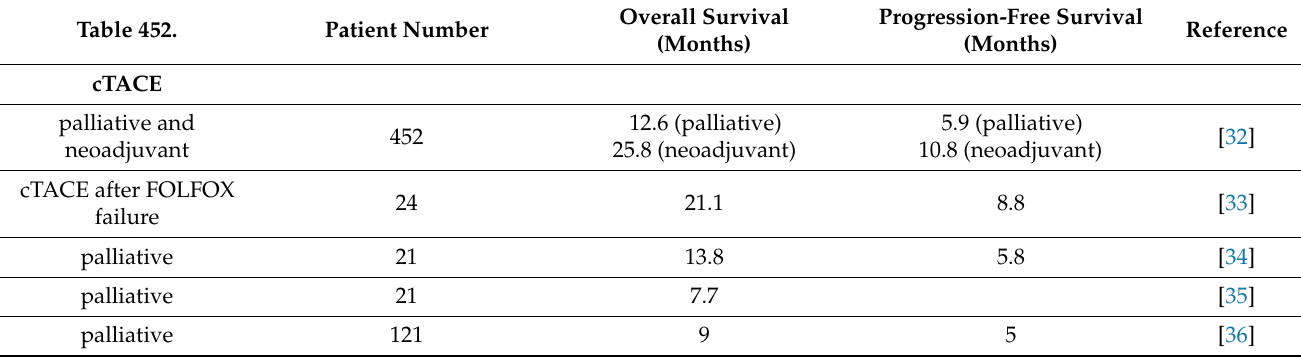
Table 1. Overview of studies on cTACE and DEB-TACE. Table